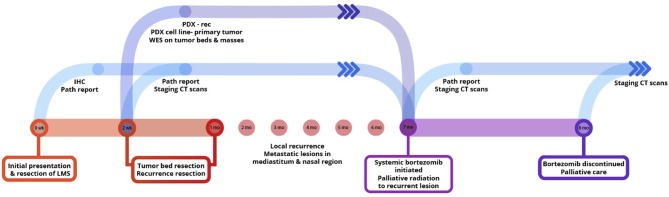
An integrated preclinical drug discovery and validation pipeline. A 3 years old canine patient with synchronous leiomyosarcomas (LMS) was identified and recruited based on high risk of disease recurrence. Using both in vitro and in vivo patient-derived models, we identified proteasome inhibitors as candidates for validation in clinic. Clinicians applied the information from this preclinical pipeline for the treatment of the patient's recurrent and metastatic disease.